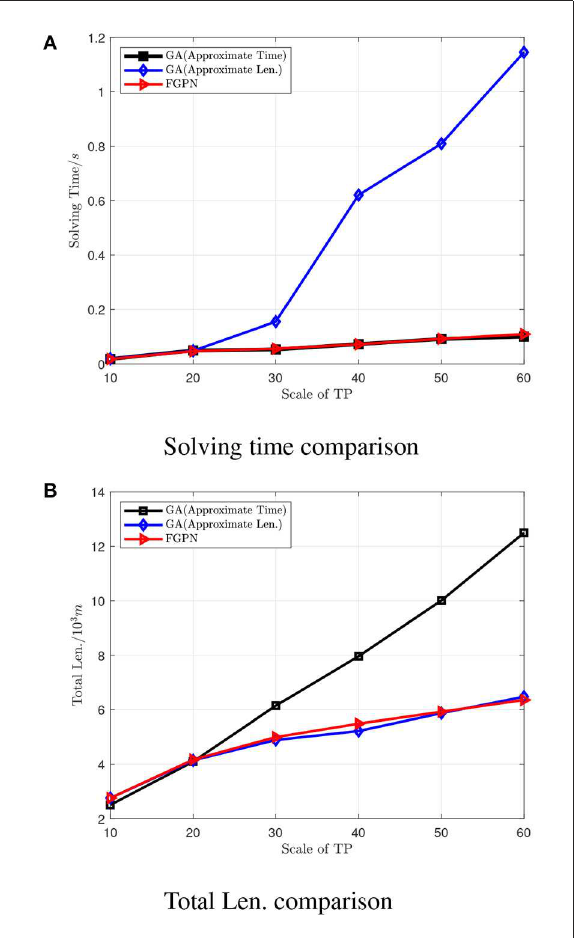
FIGURE4 Comparison of solution times for the number of target task nodes at different scales. (A) Comparison of solution speed between GA algorithm and FGPN method when the solution results are similar. (B) Comparison of the solution results of the GA algorithm and the FGPN method when the solution speed is